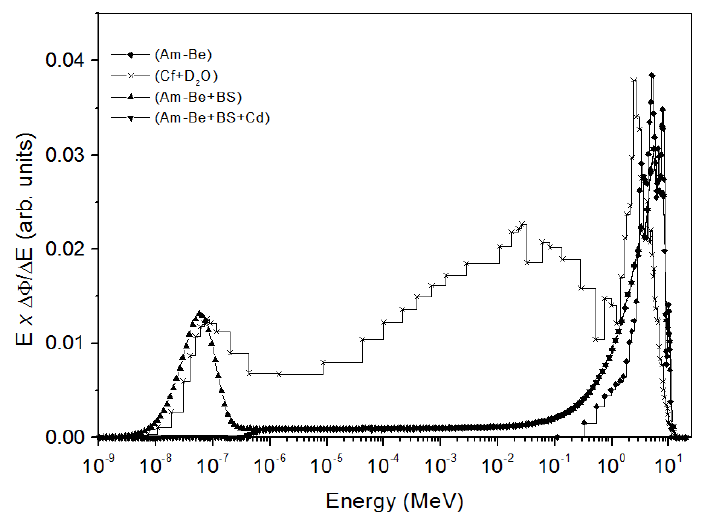
Figure 2. Neutron spectra emitted from 241 Am − Be, 241 Am − Be + BS, ( 241 Am − Be + BS + Cd), and ( 252 Cf + D 2 O) sources. BS is Bonner Sphere.